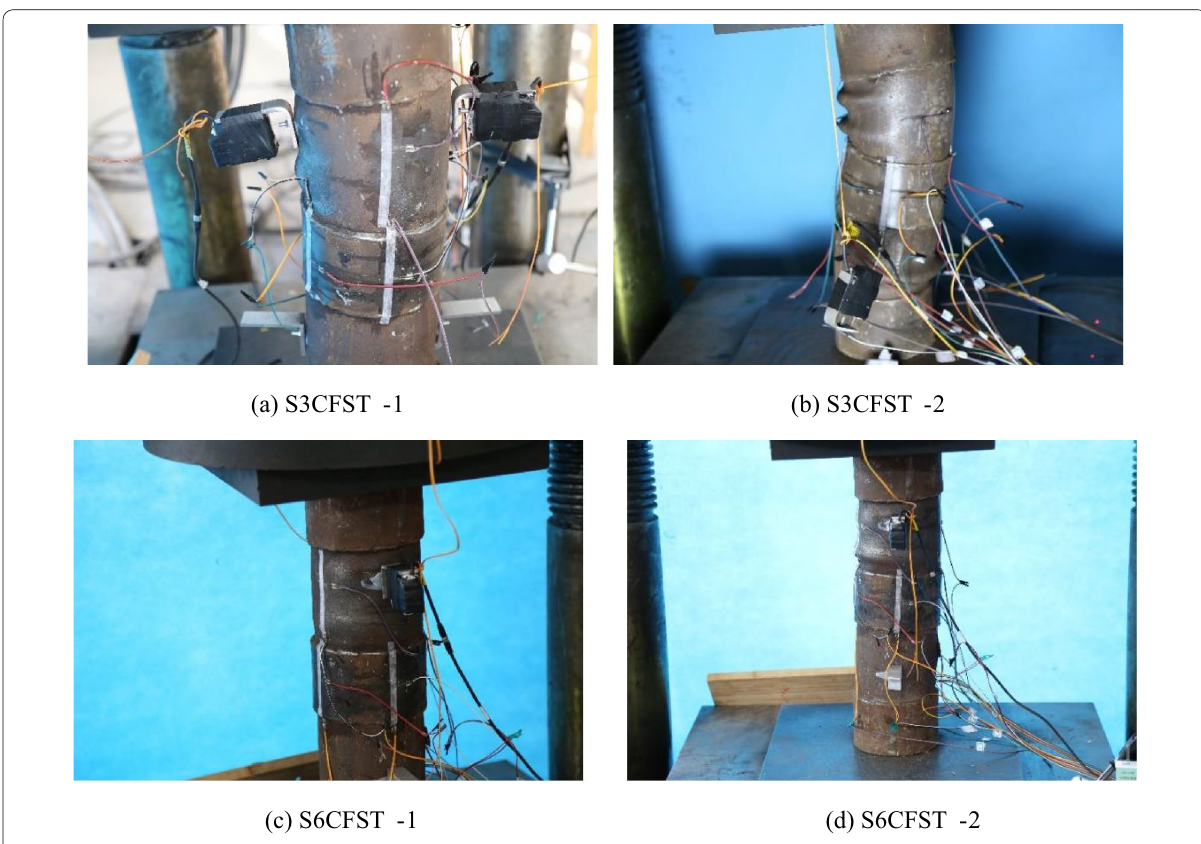
Fig. 10 Failure mode of welded steel strip-strengthened CFST columns